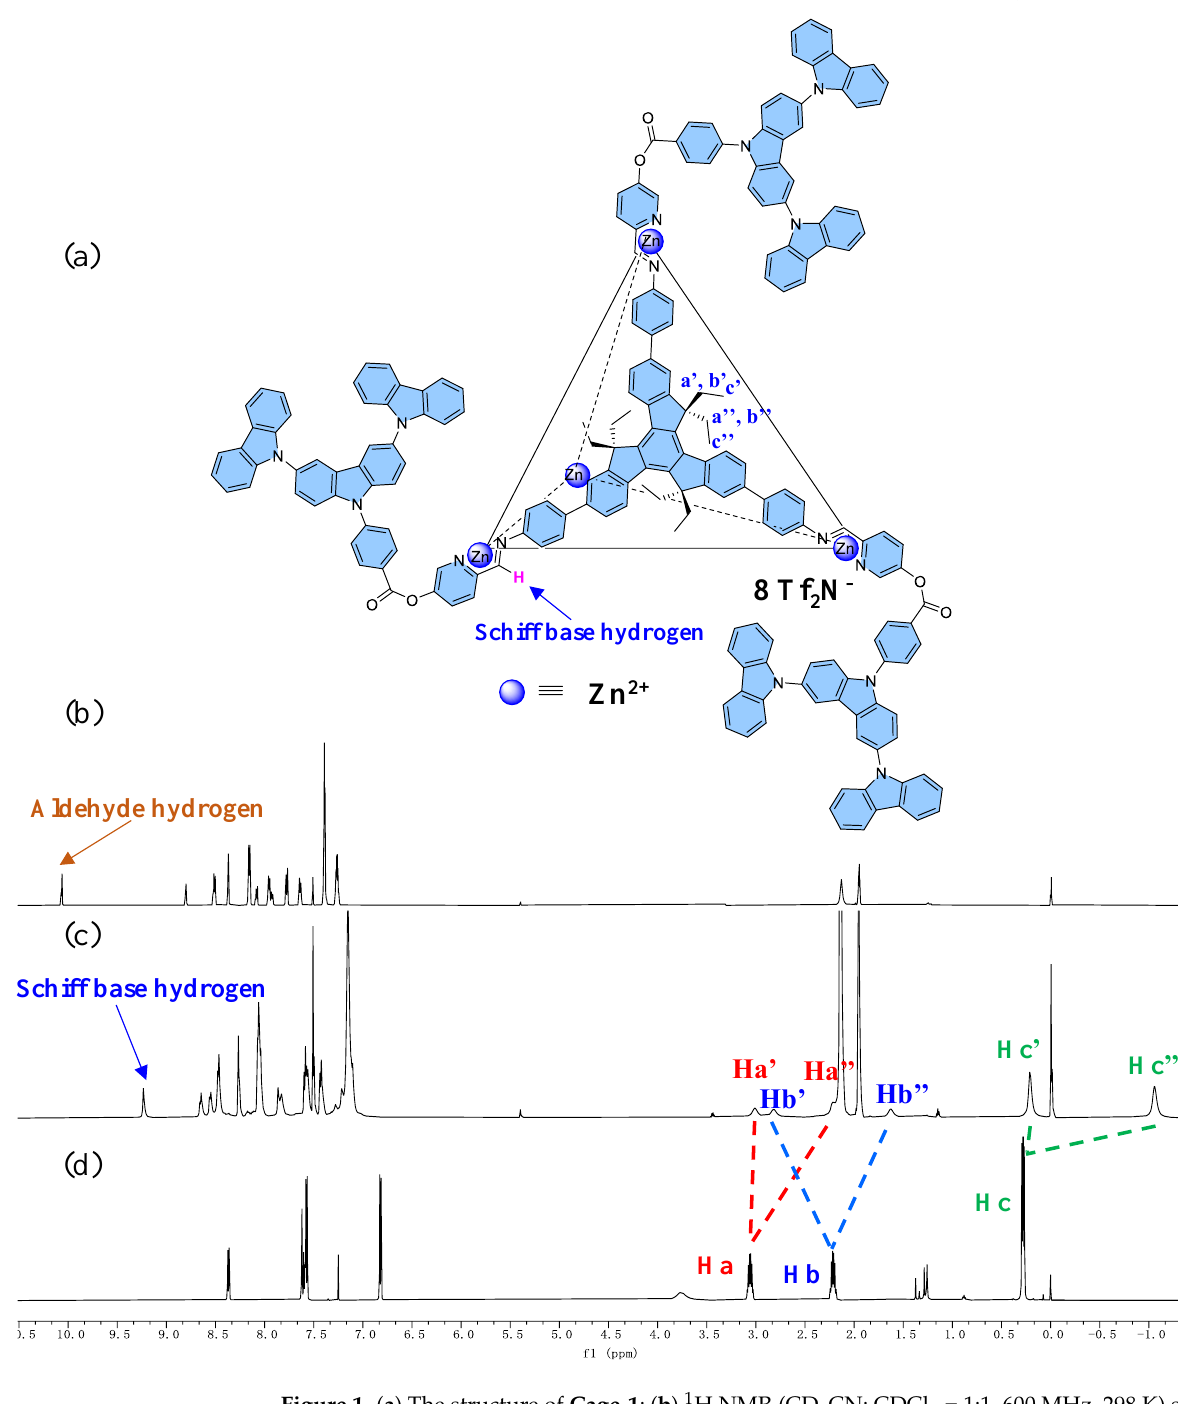
Figure 1. ( a ) The structure of Cage-1 ; ( b ) 1 H NMR (CD 3 CN: CDCl 3 = 1:1, 600 MHz, 298 K) spectrum of ligand LA ; ( c ) 1 H NMR (CD 3 CN: CDCl 3 = 1:1, 600 MHz, 298 K) spectrum of Cage-1 ; ( d ) 1 H NMR (CD 3 CN, 600 MHZ, 298 K) spectrum of ligand LB .